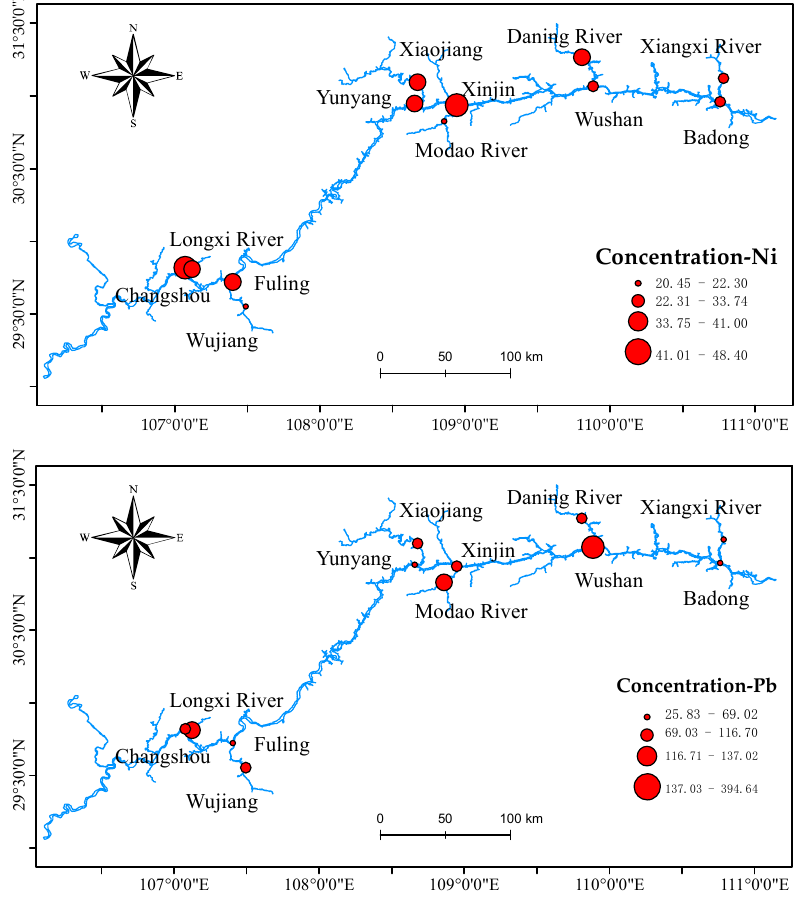
Figure 2. Concentration maps of heavy metals in surface sediments from the Three Gorges Reservoir. Table 3 shows that compared with the background values of heavy metal concentrations in the sediments of the Yangtze River in the 1990s, the average values of Ni, Cu, Zn, Pb, Cd, Cr, and As were relatively higher. Only the average value of Hg was lower. The highest concentrations of Cu, Zn, Pb, and Cr were respectively 9.6, 5.51, 14.62, and 2.26 times the background values of the Yangtze River sediments. Compared with the national second-level standard of soil quality in China (GB15618-2008), different proportions of Cu, Zn, Pb, and Cd in the surface sediments of the Three Gorges Reservoir exceeded the standard. The Pb content in the different sites was higher than the standard by 66.67%. In contrast with the standard limit of 80 mg/kg, the concentration in Wushan was 394.7 mg/kg. The coefficients of variation for Cr and Ni in the surface sediments of the Three Gorges Reservoir were small, while those of Cu, Zn, Pb, Cd, Hg, and As (37.63–87.68%) were all greater than 36%, indicating a high level of variation [24]. In particular, the coefficients of variation of Cu, Pb, and Hg were all greater than 80%, indicating that the concentrations of these three elements vary greatly at different sampling points, and their distribution is uneven in different tributaries.